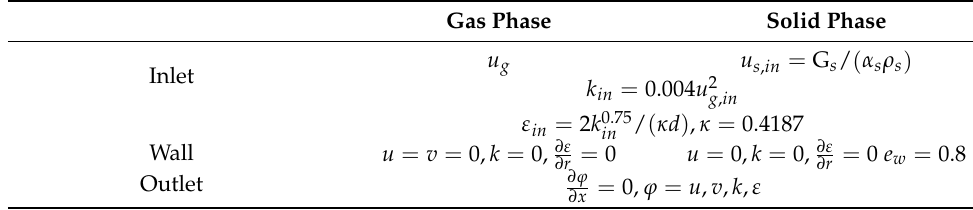
Table 5. Boundary